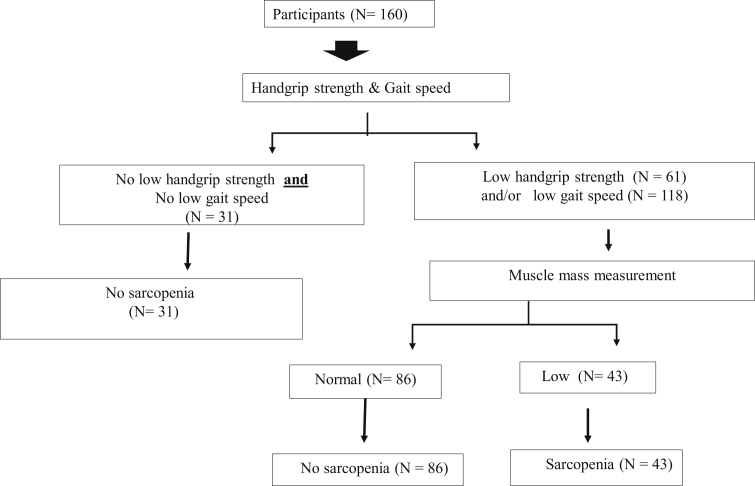
Sarcopenia category by diagnostic algorithms of Asian Working Group for Sarcopenia at preoperative open heart surgery.